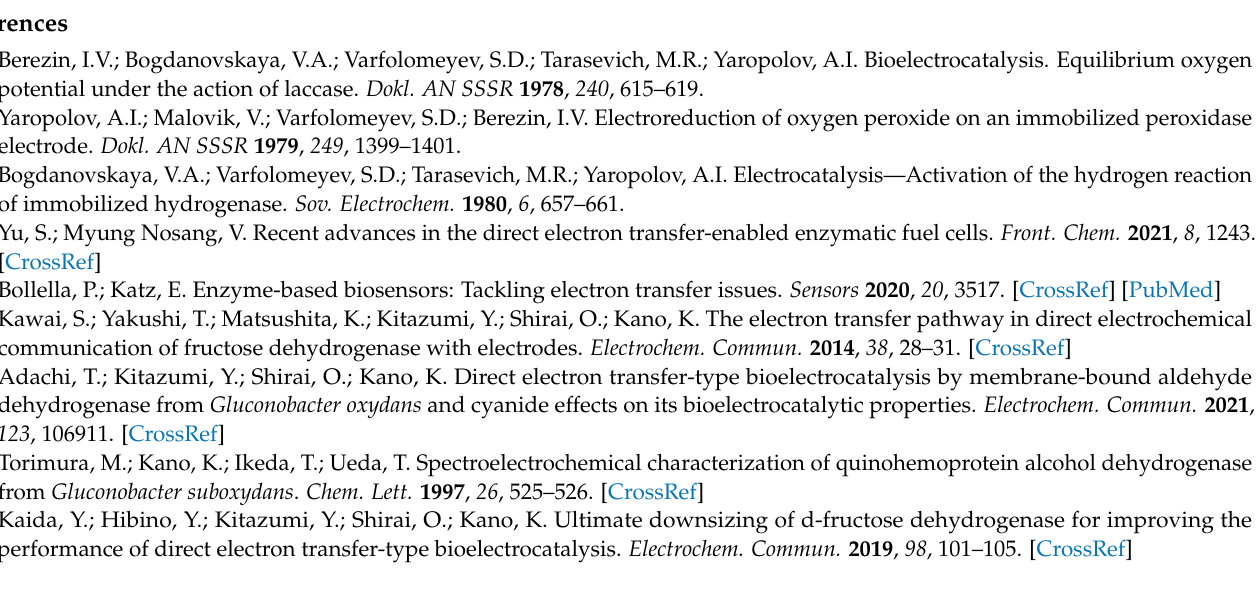
impedance, Figure S3: Respiratory activity of membrane fractions in the presence of glucose (0.5 mM) as a function of their concentration in a bioreceptor, Figure S4: TEG/PEDOT:PSS/PEGDE biosensor signals in response to the addition of 0.5 mM glucose at various applied potentials (vs Ag/AgCl) without the presence of redox